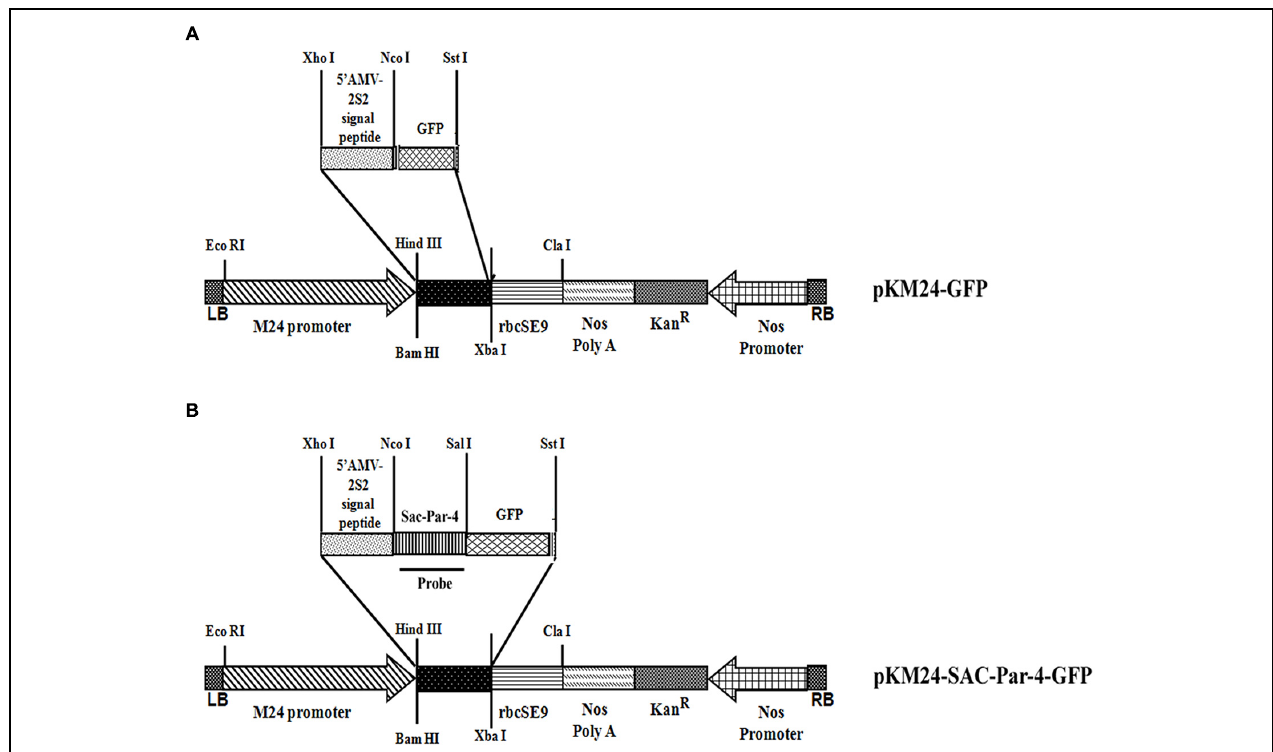
FIGURE 1 | Schematic representation of the constructs. (A) Plant expression vector containing GFP (pKM24-GFP; VC); (B) the synthetic SAC-Par-4 gene fused in-frame with GFP (pKM24-SAC-Par-4-GFP). LB: left T-DNA border; RB: right T-DNA border; 5 (cid:2) AMV: a translational enhancer sequence; aTP: the apoplast targeting sequence of the Arabidopsis 2S2 protein; M24: recombinant full-length Mirabilis mosaic virus promoter, Kan R : neomycin phosphotransferase II marker gene; rbcSE9: the 3 (cid:2) -terminator sequences (terminators) of the ribulose bisphosphate carboxylase small subunit and Nos PolyA: nopaline synthase genes are shown. The EcoR I, Xho I, Nco I, Sal I, Sst I, Hind III, Bam HI, Xba I, and Cla I restriction sites used to assemble these expression vectors are shown. The Southern and Northern hybridization probe (SAC-Par-4) is indicated by thick line in (B) .